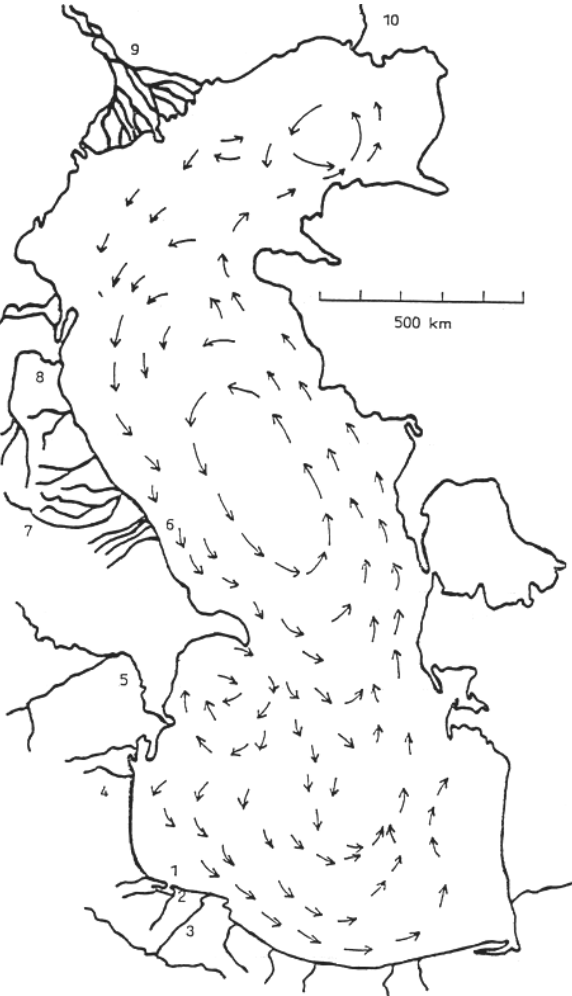
Figure 1. Schematic representation of the Caspian Sea currents (Lednev,